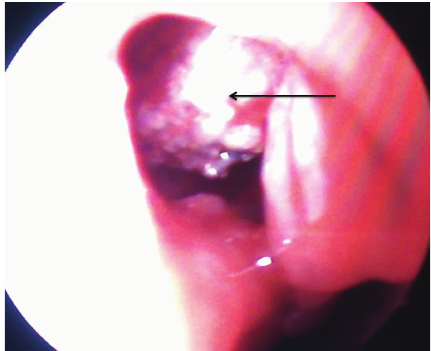
Figure 4: A wide middle meatal antrostomy revealing